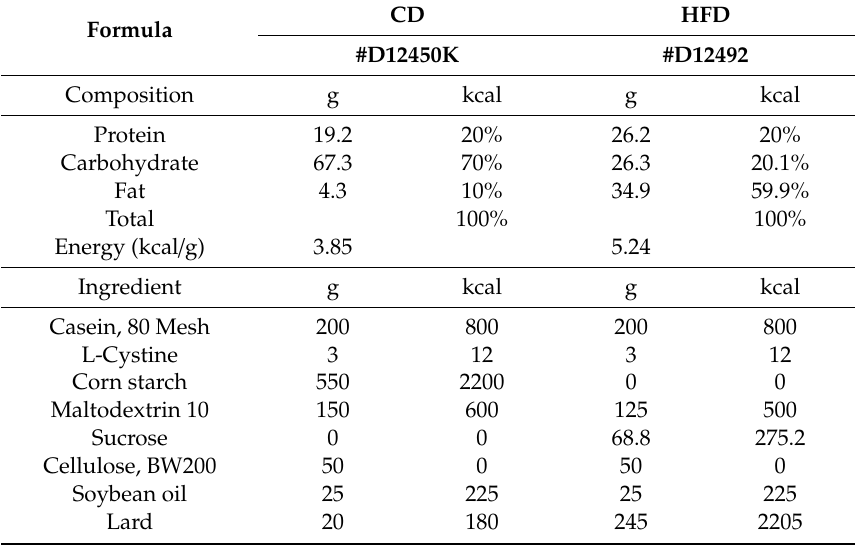
Table 1. Diet composition of the CD and HFD formulas (Research Diets, New Brunswick, NJ, USA). Formula